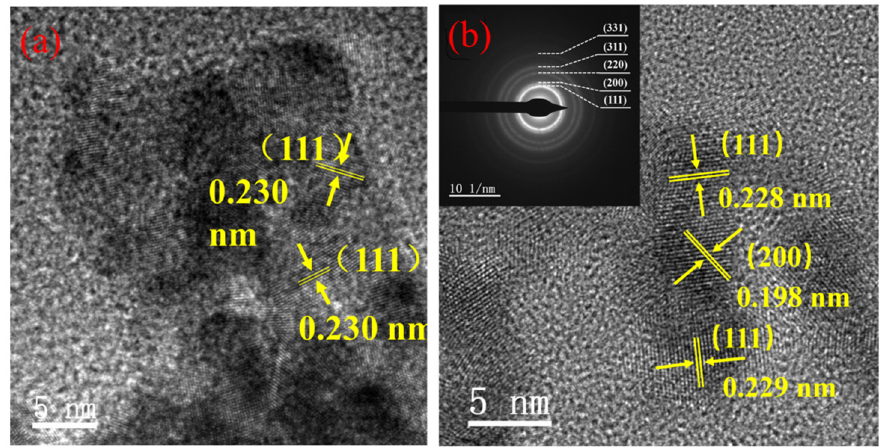
Figure 2. ( a ) HRTEM image of nano-Pd and ( b ) nano-Fe/Pd (Inset shows the corresponding SAED pattern).